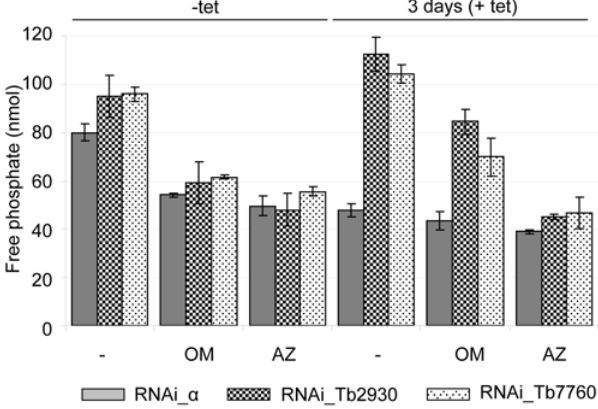
Figure 7. Effect of RNAi-mediated ablation of subunits a , Tb7760 or Tb2930 on mitochondrial ATPase activity. Crude mitochondrial preparations from uninduced and 3 days RNAi-silenced cells were obtained by digitonin extraction and ATPase activity was assayed by measuring release of free phosphate. Shown are data for RNAi_sub a (grey columns), RNAi_Tb2930 (small checker board columns) and RNAi_7760 (dotted diamonds columns) cell lines uninduced and induced for three days. ATP synthase inhibitors oligomycin (OM, 2.5 m g/ml) and azide (AZ, 1 mM) were added as indicated. Average numbers for three assays are shown, using extract preparation from three independent RNAi experiments.